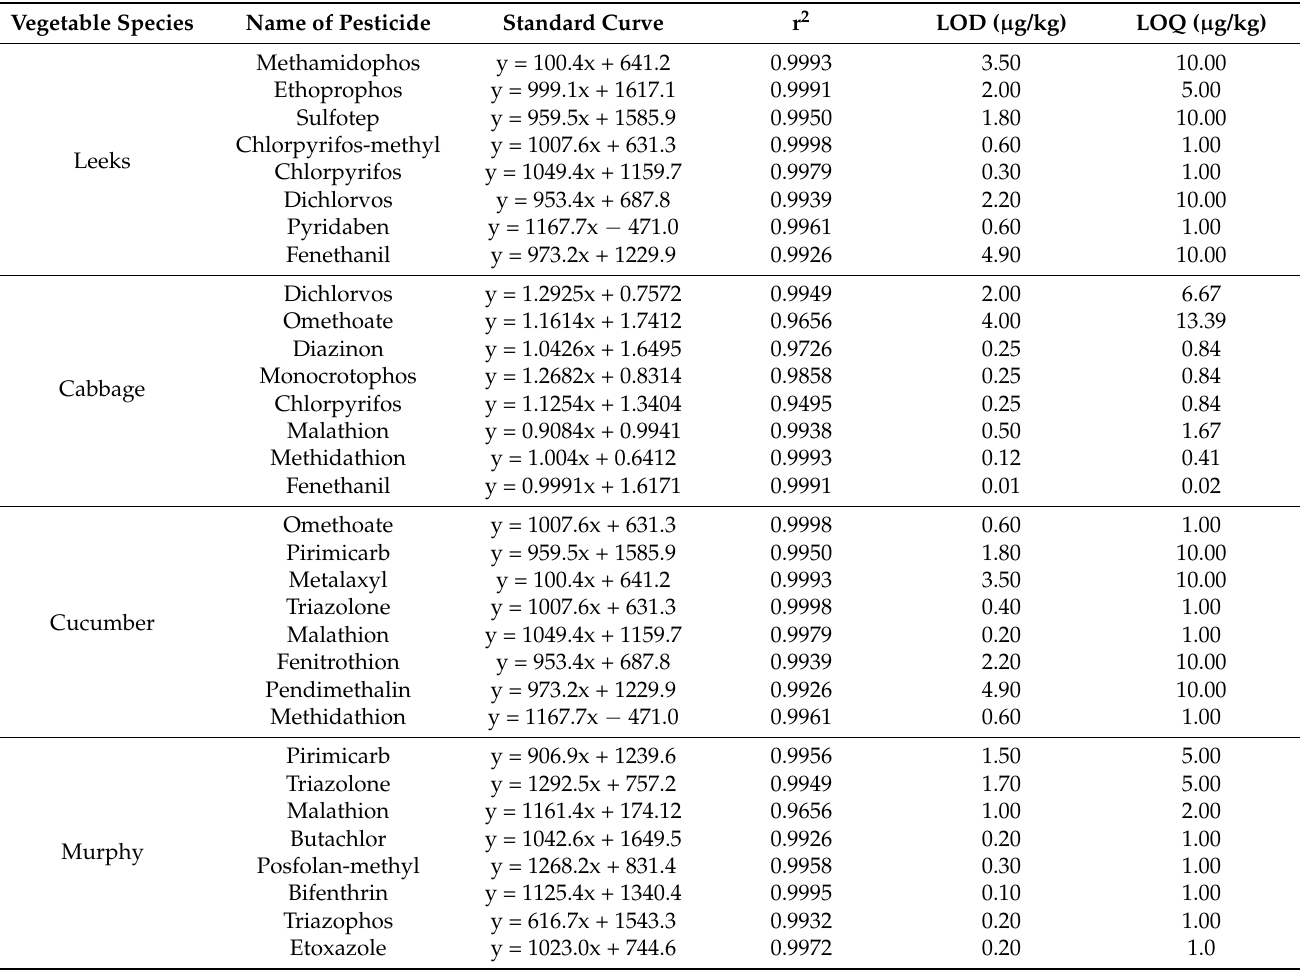
Table 1. The standard curve, LOD, LOQ of different pesticide in the four vegetables.